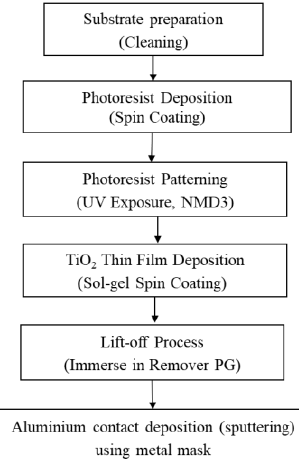
Figure 4. Graphical view of PDMS attachment process using adhesive bonding technique.